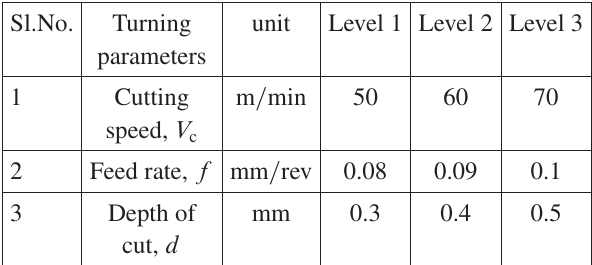
are assumed. For a three factor with three levels, Taguchi had specified L27 orthogonal array for